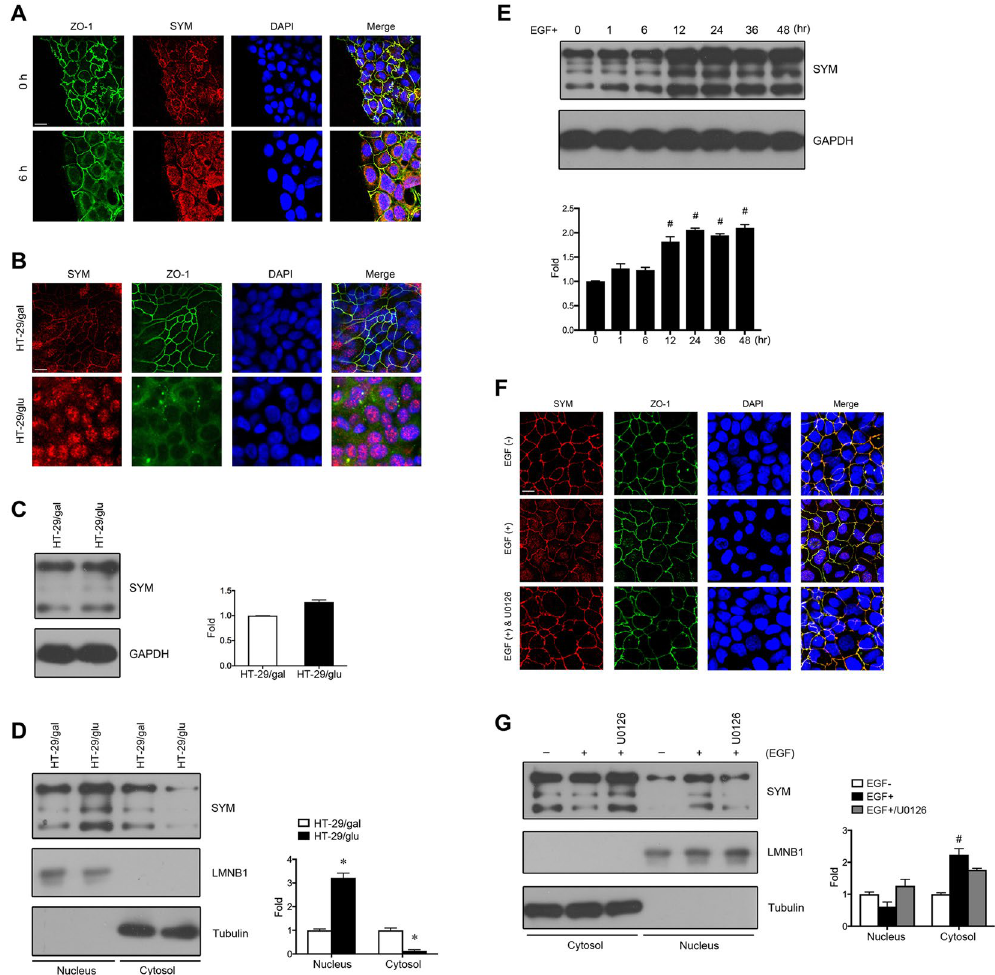
Figure 1. Expression and distribution of symplekin in dedifferentiated cells. ( A ) A confluent Caco-2 cell monolayer was scratched with a 1-ml pipette tip. Symplekin (SYM) and a tight junction marker (ZO-1) were immuno-stained at 0 hr and 6 hr after wound healing. Nuclei were stained with DAPI (blue). ( B ) Symplekin and ZO-1 staining in HT-29 cells cultured in glucose-free medium supplemented with galactose (HT-29/gal) or glucose (HT-29/glu). ( C ) Representative WB bands and relative densitometric quantification of total symplekin expression in HT-29/gal and HT-29/glu cells. ( D ) Representative WB bands of cytoplasmic/membrane (Cytosol) and nuclear (Nucleus) distribution of symplekin in HT-29/gal and HT-29/glu cells. Cytoplasmic tubulin and nuclear lamin B1 (LMNB1) were used as controls for quantification analysis, respectively. ( E ) Symplekin expression levels in starved Caco-2 cells treated with EGF for different time periods shown by bands of WB and relative quantitative graphs. ( F ) The localization of symplekin and ZO-1 in Caco-2 cells with ( + ) or without ( − ) EGF treatment. Cells were pre-treated with U0126 (40 μ M) for 30 min before EGF stimulation. ( G ) Western blot for symplekin in Caco-2 cell fractions with or without EGF or U0126 treatment. The protein levels were normalized to those of tubulin and LMNB1, respectively. * P < 0.05, Student’s t-test. # P < 0.05, one-way ANOVA and Student’s t-test. All data are means ± SD, n = 3. Bars, 20 μ